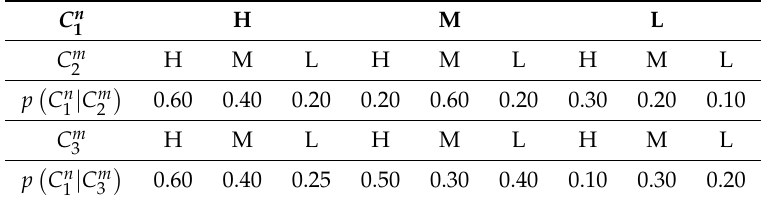
Table 5. Conditional Probability of Microgrid